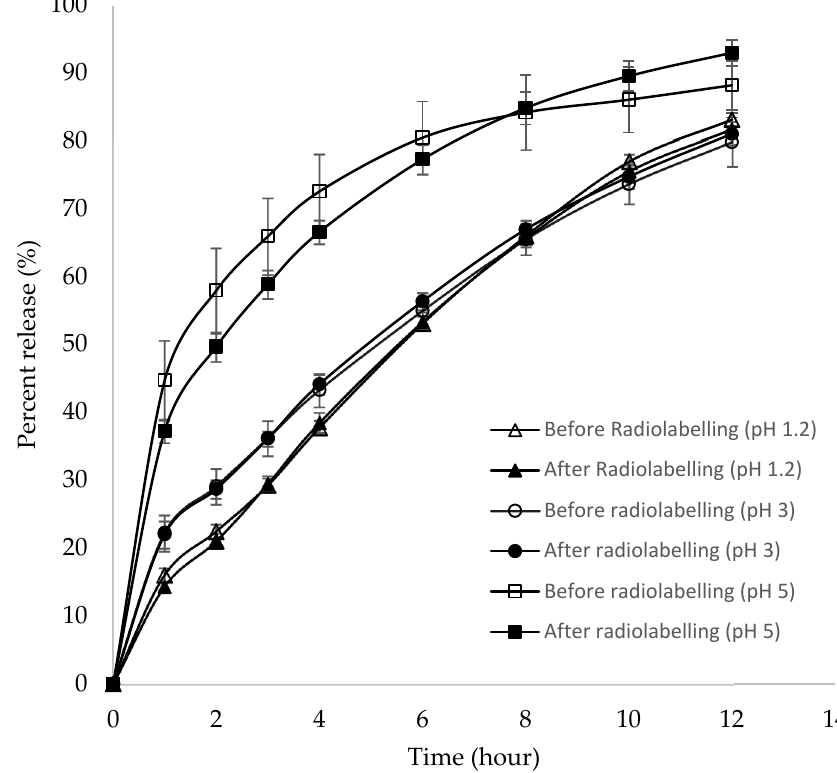
Figure 2. Dissolution profiles of the floating tablets before and after radiolabeling at pH 1.2, 3, and 5 ( n = 6, mean ± SD).